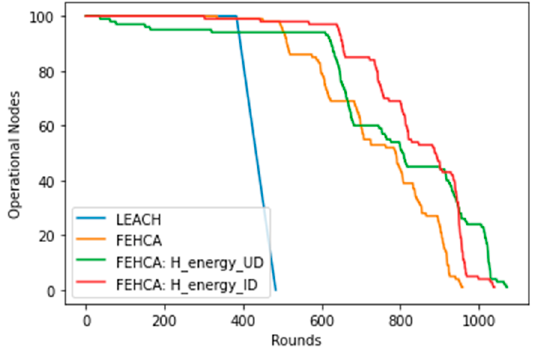
Figure 19. Performance of FEHCA and LEACH in terms of operational nodes per round when BS is positioned outside the deployment area.